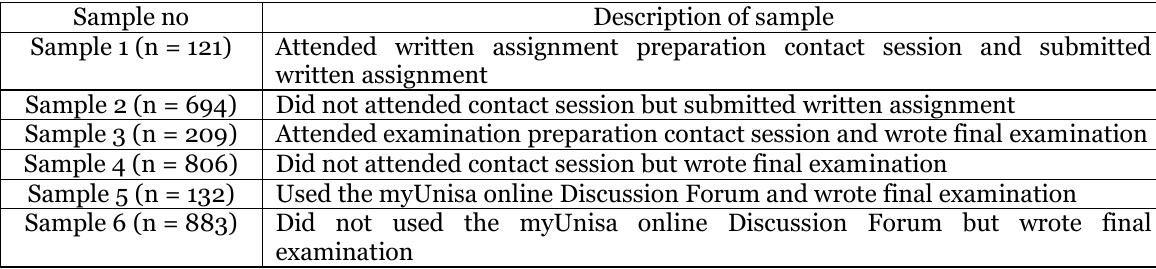
The Six Research Samples (Source: Unisa Student Record System, 2013)